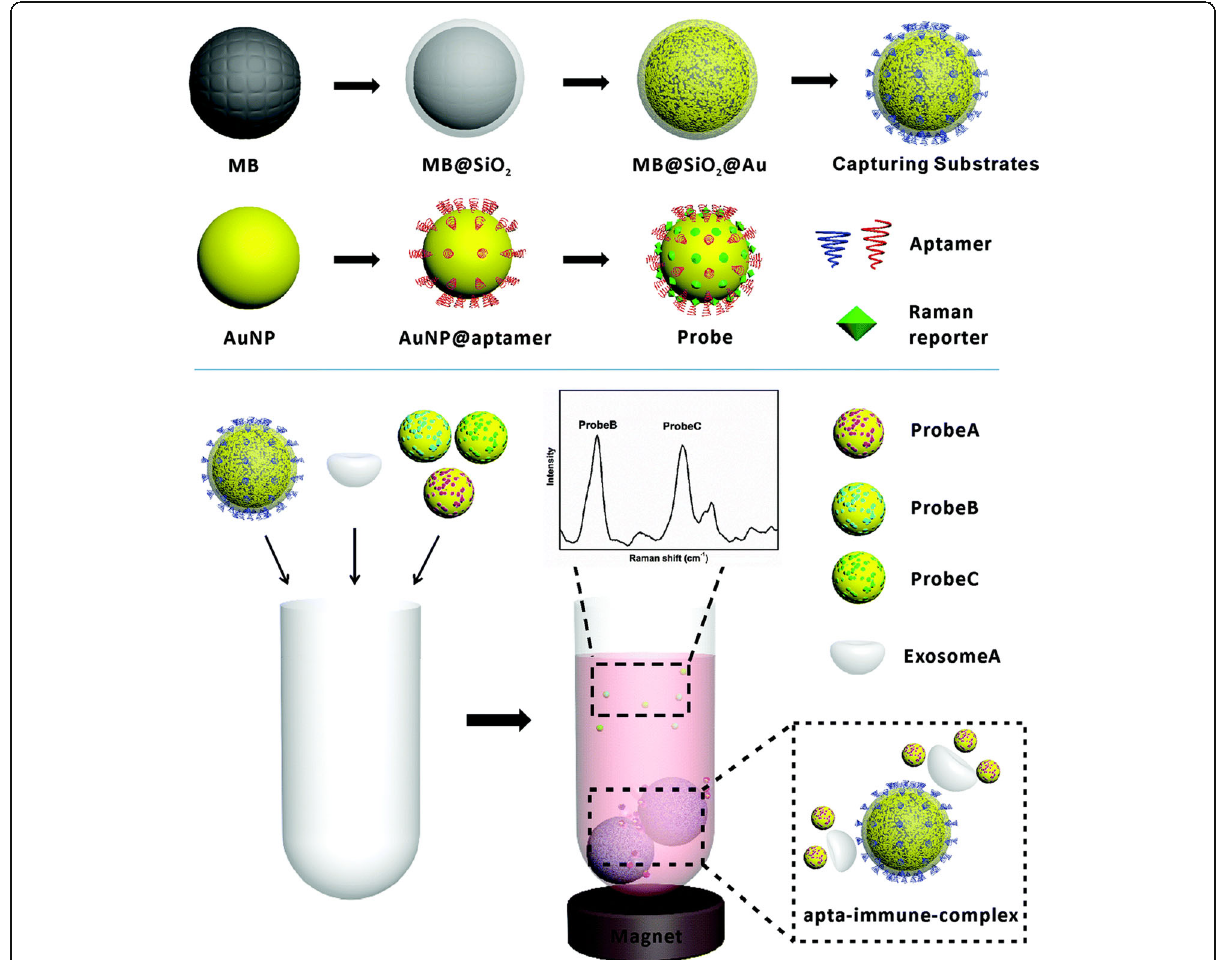
Fig. 8 The principle of SERS-based detection method for exosomes [171]. Copyright© Royal Society of